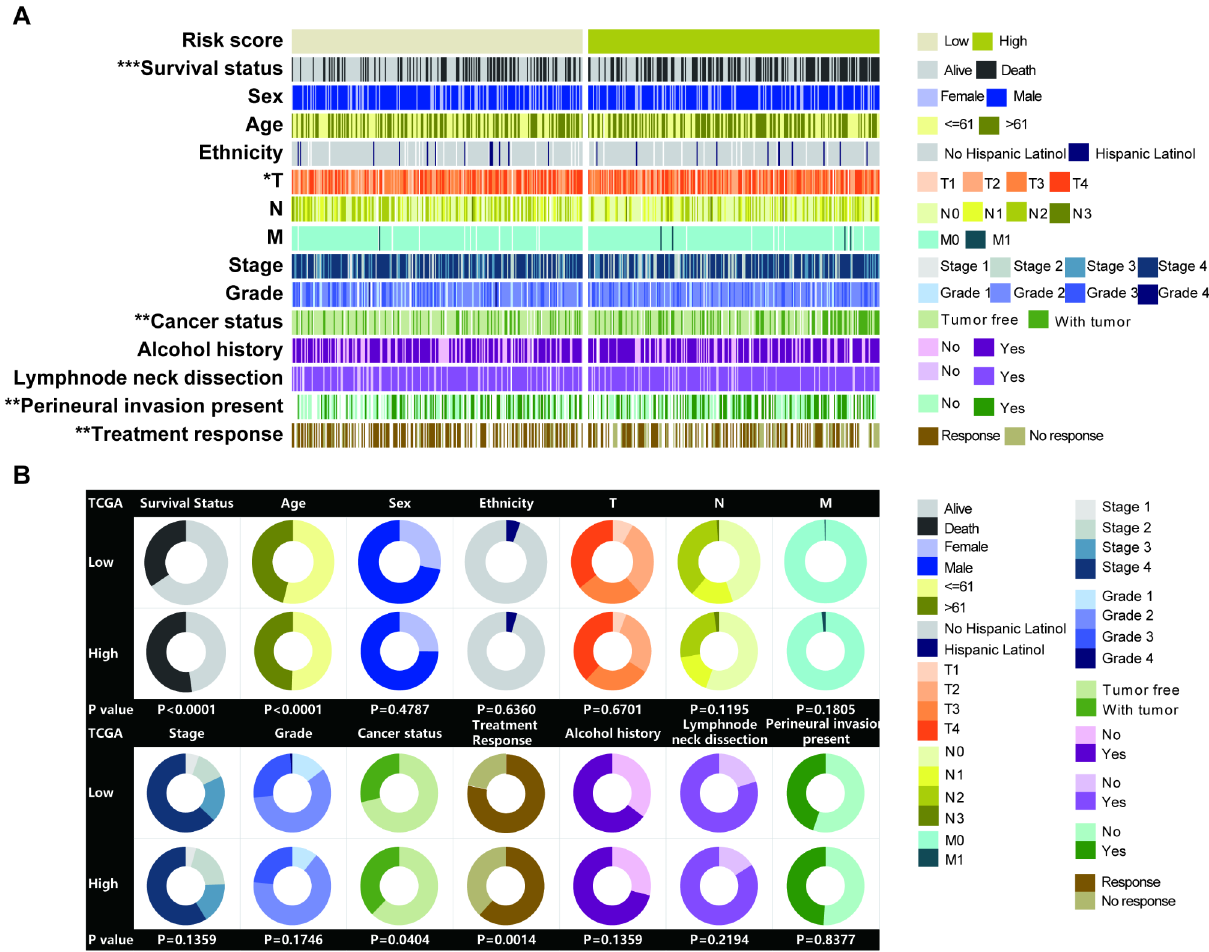
Fig. 8 The ERS-related signature is a potential predictor for immunotherapy response in HNSCC. ( A ) The correlation of the ERS-related signature with the expression levels of check-point genes in HNSC from the TCGA. R: Spearman’s correlation coefficient. ( B ) The expression levels of check-point genes among HNSCC samples grouped by risk score in TCGA dataset. Figure S1. Different expression levels of ASNS ( A ) and EXOSC8 ( B ) between normal and tumor samples in